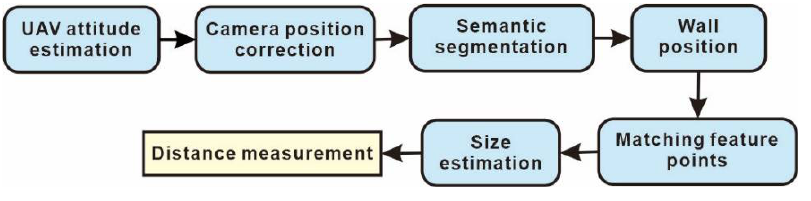
Figure 2. System overview.